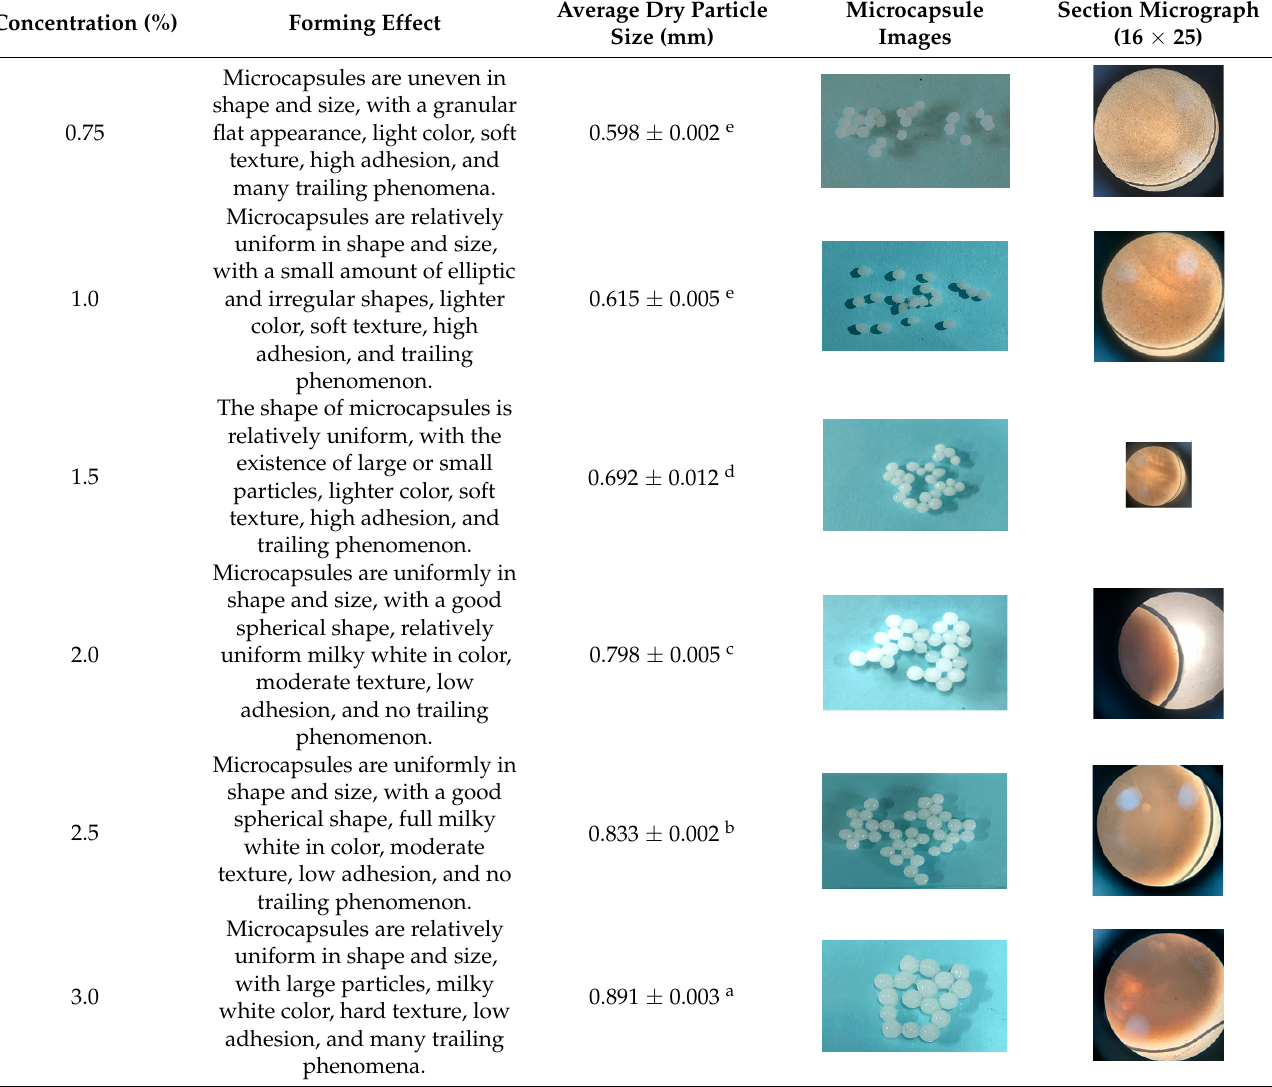
Table 2. Effect of the amount BEOs on microcapsule formation.